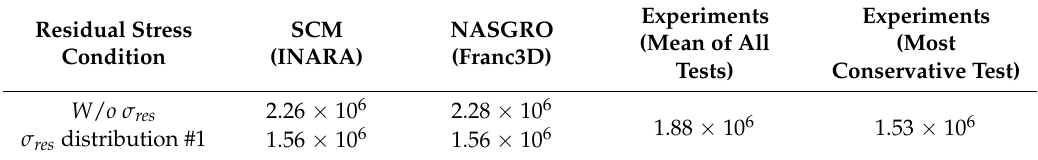
Table 3. Comparison of residual lifetime for calculations and experiments at 2 s = 15